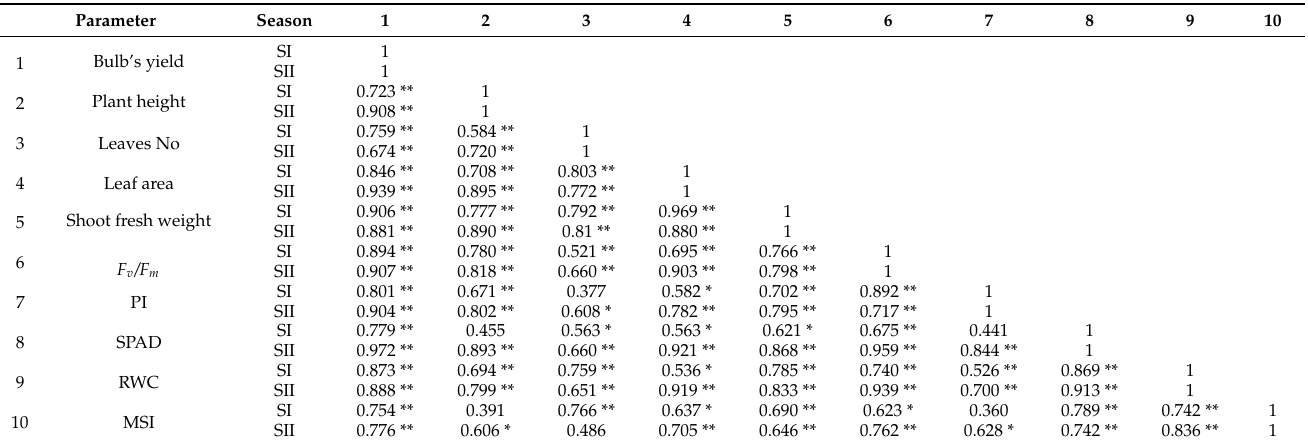
Table 8. A matrix of simple correlation coefficient between onion yield and other important traits estimated in 2016/17 (SI) and 2017/18 (SII)